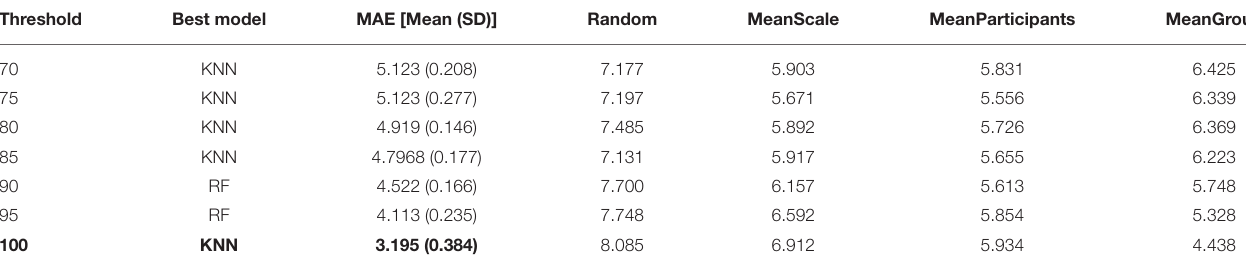
TABLE 7 | Best score achieved by the model to predict task difficulty at each threshold of task performance. Threshold